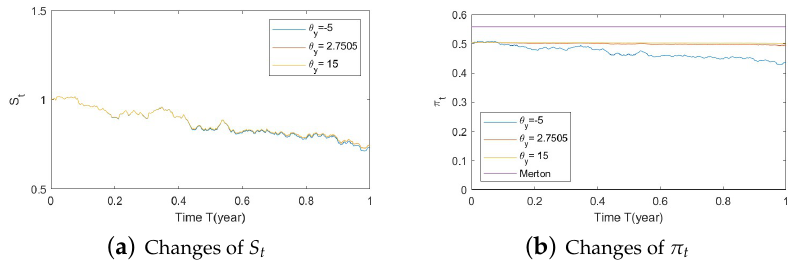
Figure A32. Illustrate the impact on ( a ) stock prices and ( b ) optimal stock allocations when varying θ y ( e . g ., θ y = − 5,2.7505,15 ) .